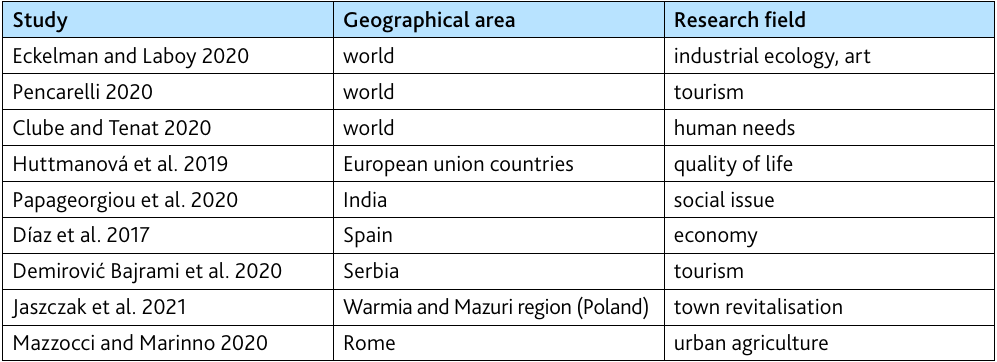
Table 4. Studies of human well-being identified in this review